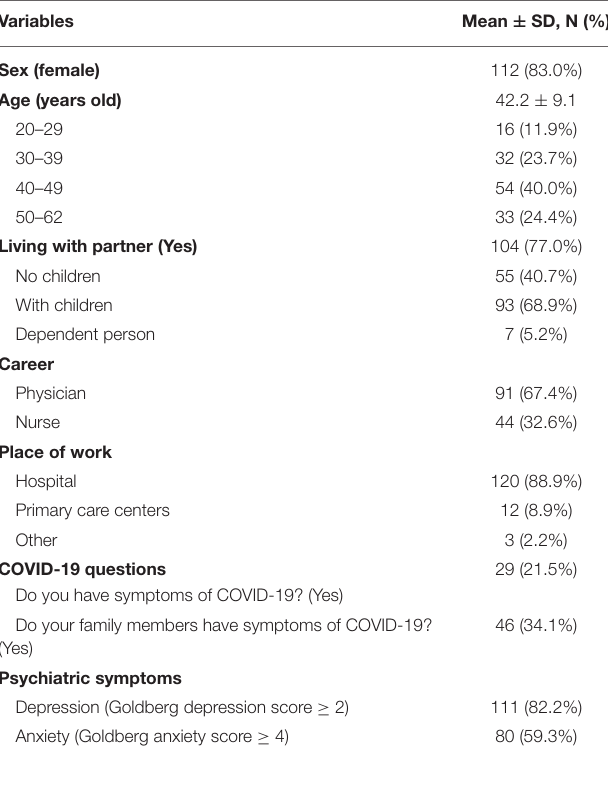
TABLE 1 | Demographic characteristics of participants ( N = 135).